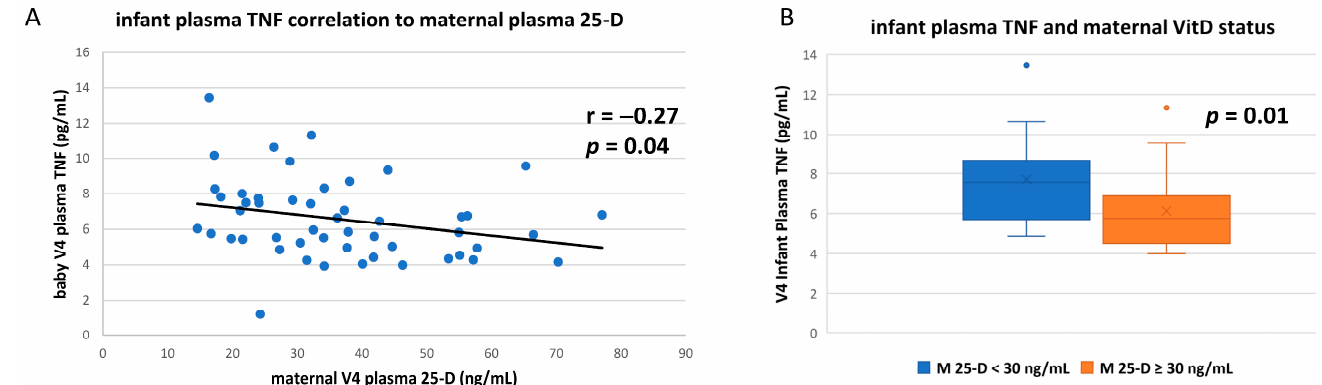
Figure 2. Infant plasma TNF correlation to maternal vitD status. ( A ) From blood draws at study com- pletion, plasma concentrations of total 25-D from mothers were compared to plasma concentrations of the TNF cytokine in their breastfeeding infants (Pearson linear correlation). ( B ) Mean infant plasma TNF concentrations compared based on maternal vitD sufficiency (i.e., plasma 25-D ≥ 30 ng/mL) (unpaired t